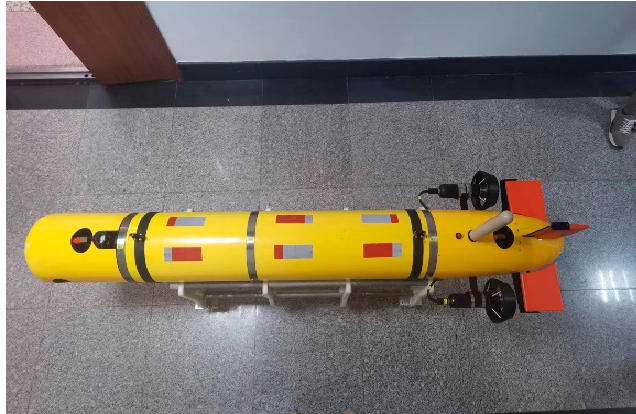
Figure 26. An AUV of Harbin Engineering University.